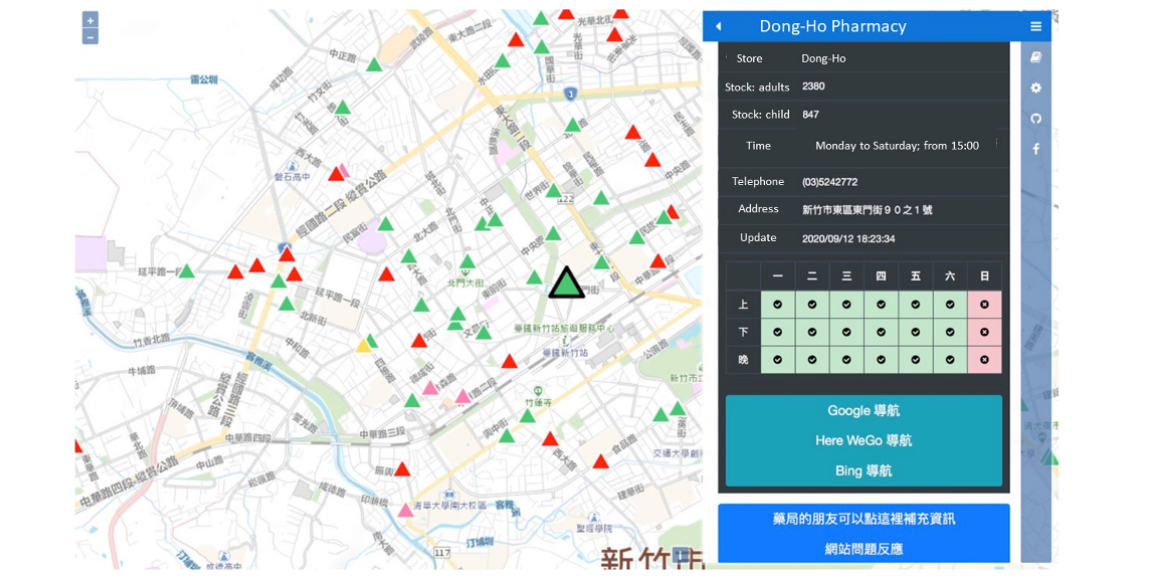
Figure 3. Mask rationing plan 2.0. Screenshot of a map-view software application for face mask availability. Mask purchases can be made by reservation using a mobile app and are available for purchase at convenience stores. Digital mapping software displays information including the pharmacy name, available quantity of adult-sized masks, available quantity of child-sized masks, opening hours, pharmacy phone number, pharmacy address, update time, and opening hours of nearby pharmacies. The triangle colors correspond to the availability of different types of masks or data about masks.